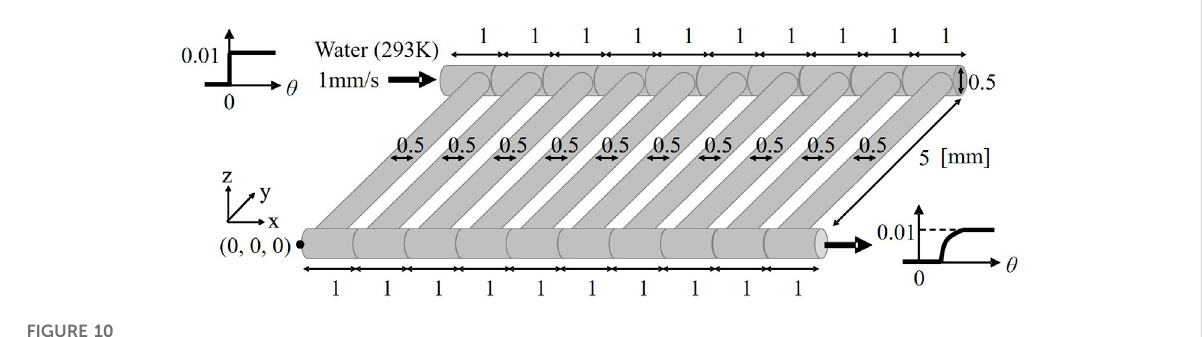
FIGURE 10 Compartmentalized multichannel